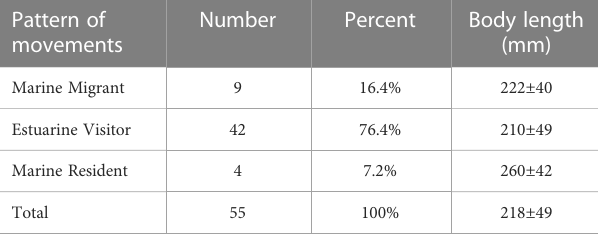
TABLE 2 Percent of individuals of A. latus with each pattern of movements in the RW according to the Sr/Ca ratios in otoliths. Pattern of